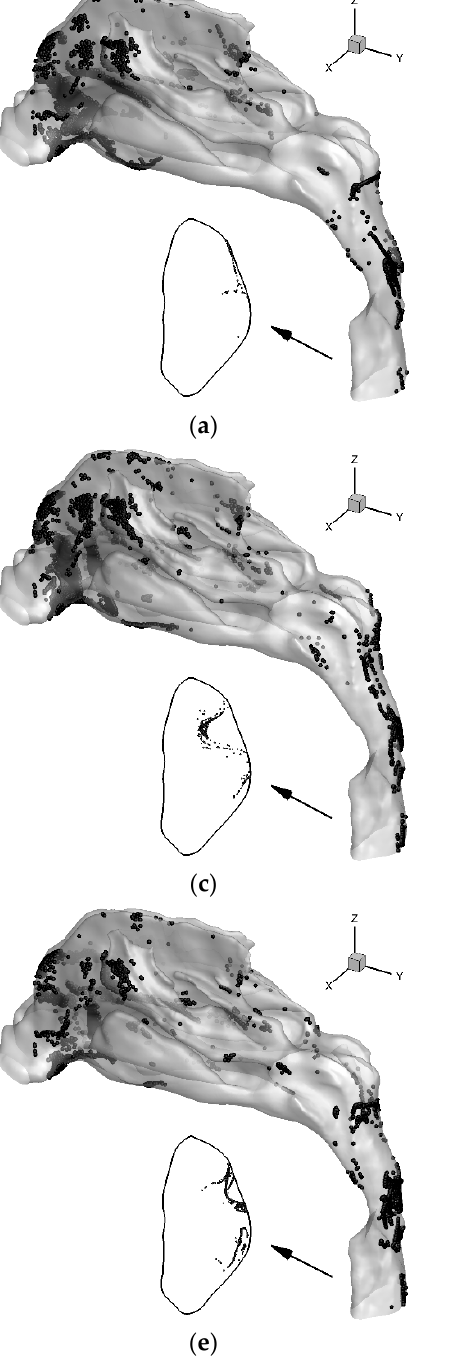
Figure 6. Final locations for the deposited and escaped 6 μ m particles for the nose-to-throat models at Q in = 60 L/min: ( a ) Left view of the deposition pattern and locations of escaped particles at the outlet for the original model, ( b ) Right and top views of the deposition pattern for the original model, ( c ) Left view of the deposition pattern and locations of escaped particles at the outlet for VS1 model, ( d ) Right and top views of the deposition pattern for VS1 model, ( e ) Left view of the deposition pattern and locations of escaped particles at the outlet for VS2 model, ( f ) Right and top views of the deposition pattern for VS2 model.